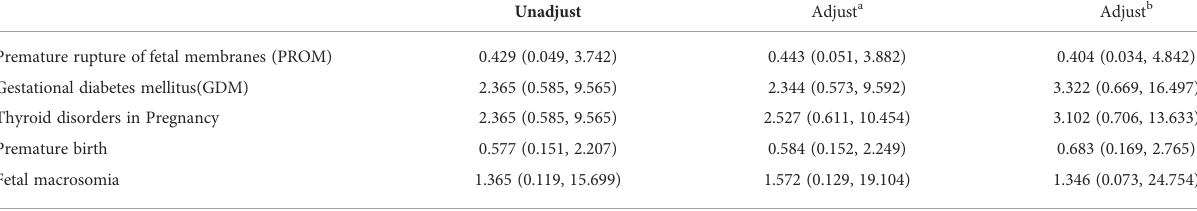
TABLE 5 Logistic regression analysis results of the history of malignant tumor correlation with pregnancy complications [ OR (95% CI )].